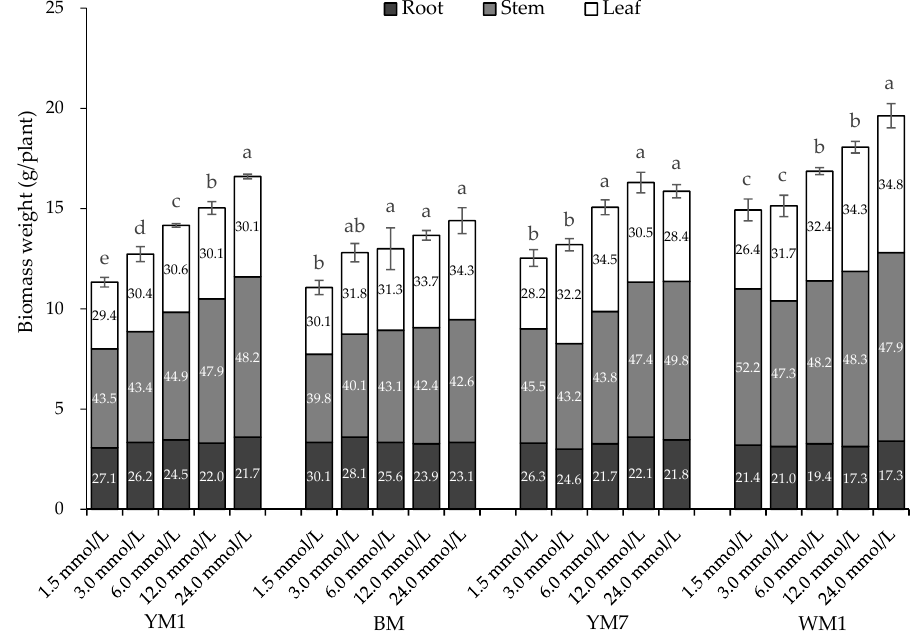
Figure 1. Effect of N treatments on hemp biomass weight. Different letters above the columns within a cultivar represent significant differences in total biomass at p = 0.05. Numbers within a column represent the percentage of root, stem, or leaf weight over the total biomass (%).